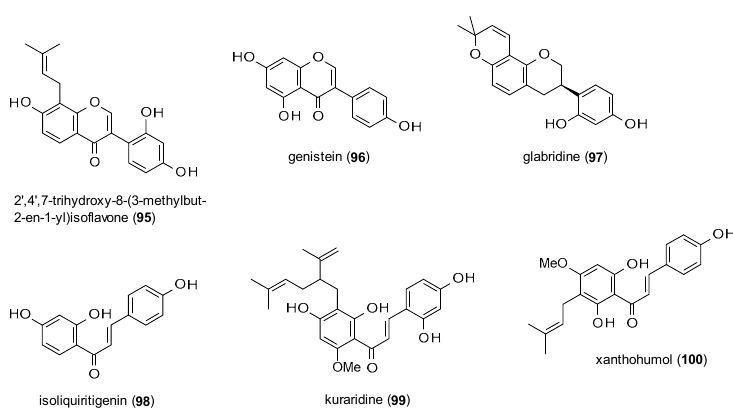
Figure 6. Chemical structures of isoflavonoids and chalcones with reported GABA(A)-receptor modulating